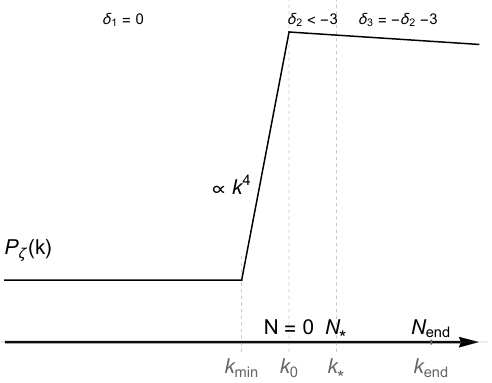
Figure 1 . Analytic template for the power spectrum of the curvature perturbation for a 3-stage constant-rate inflation with Phase 1 δ (quasi-)ultra-slow-roll